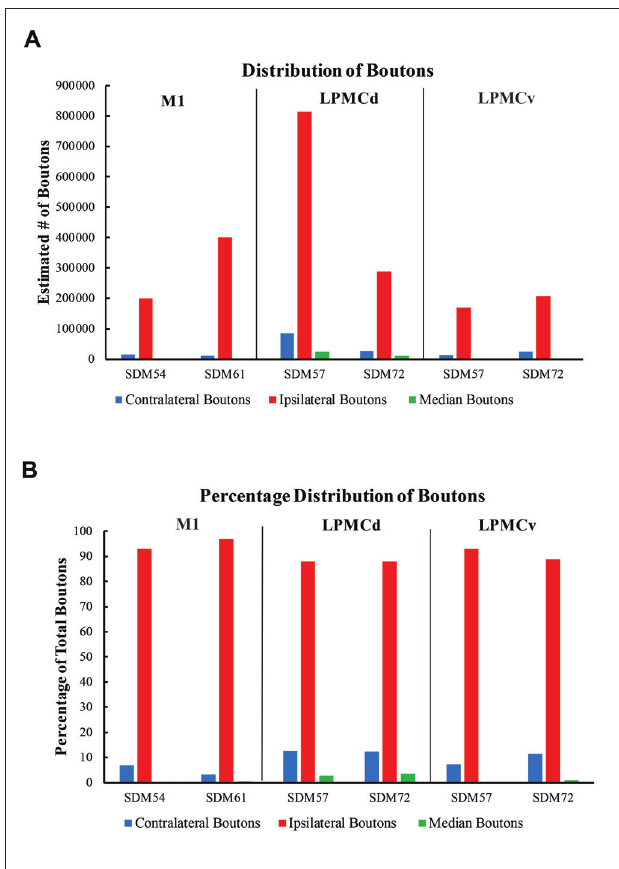
FIGURE 8 | (A) Bar graphs illustrating the total estimated number of contralateral corticopontine boutons and ipsilateral corticopontine boutons following injections of high resolution tract tracer into M1, LPMCd and LPMCv in each experimental case. (B) Bar graphs illustrating the percent distribution of the contralateral corticopontine boutons and ipsilateral corticopontine boutons following injections of high resolution tract tracer into M1, LPMCd and LPMCv in each experimental